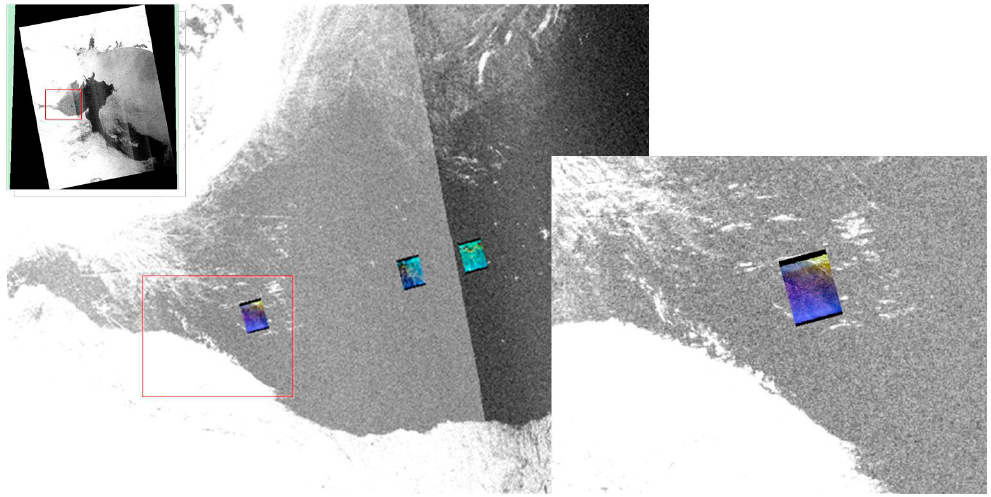
Figure 21. The identified results of this research and ASAR backscatter image captured at UTC 03:48 18 May 2010.